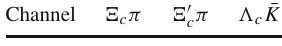
Table 12 The widths of pole 2791 . 30 + i 3 . 63 decaying to various channels (all units are in